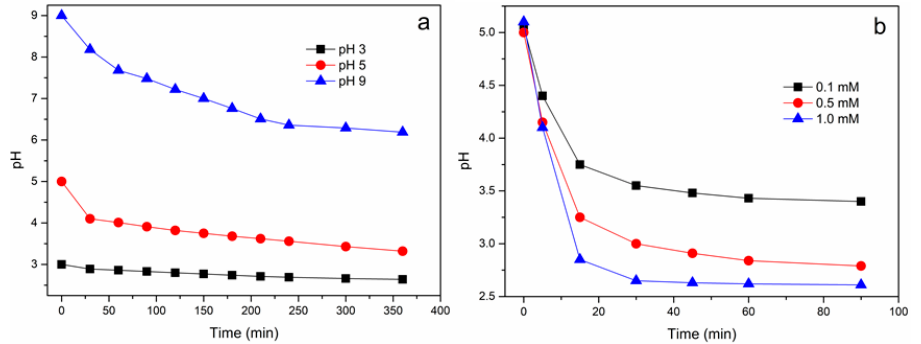
Figure 8. Changes of pH during the RhB degradation in the absence ( a ) and presence ( b ) of HA under various pH conditions. Concentrations: [Sch] = 0.5 g/L, [RhB] = 25 mM, [PS] = 5 mM, and [HA] = 0–1 mM.